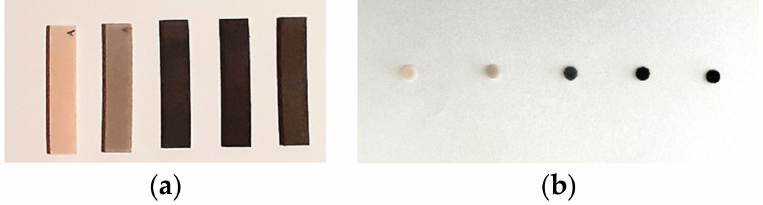
Figure 3. Printed specimens used in surface roughness measurement ( a ) and in antimicrobial activity study ( b